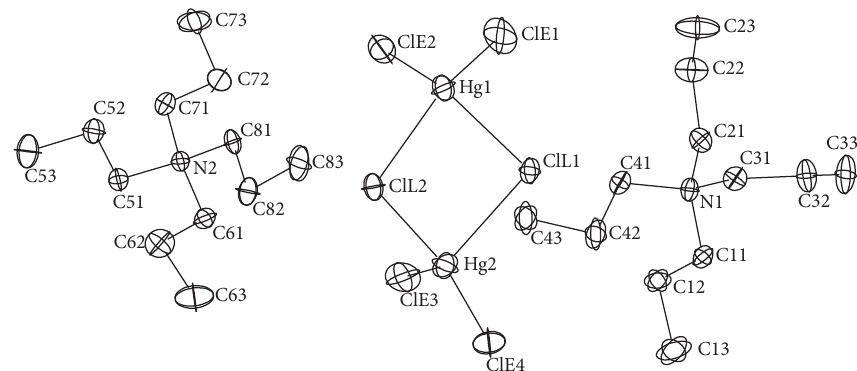
F 1: Representation of the ellipsoid of thermal mean square displacements of nonhydrogen atoms at 50